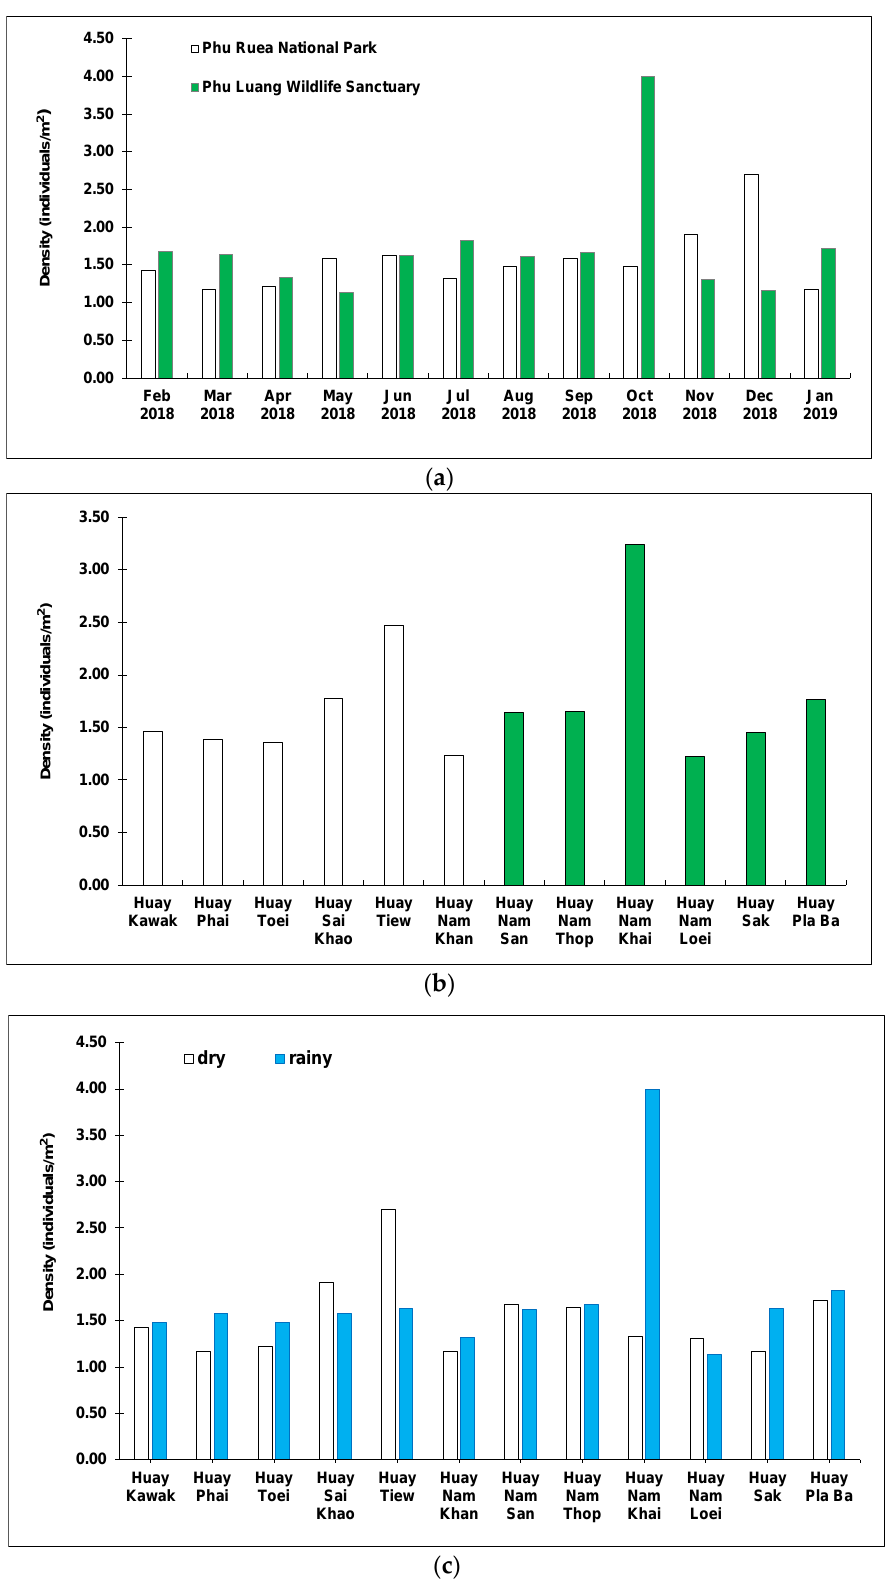
Figure 6. Density of I. bhumibol in Phu Luang Wildlife Sanctuary and Phu Ruea National Park from February 2018 to January 2019 ( a ); density in each sampling site ( b ); and density in dry and rainy seasons ( c ).